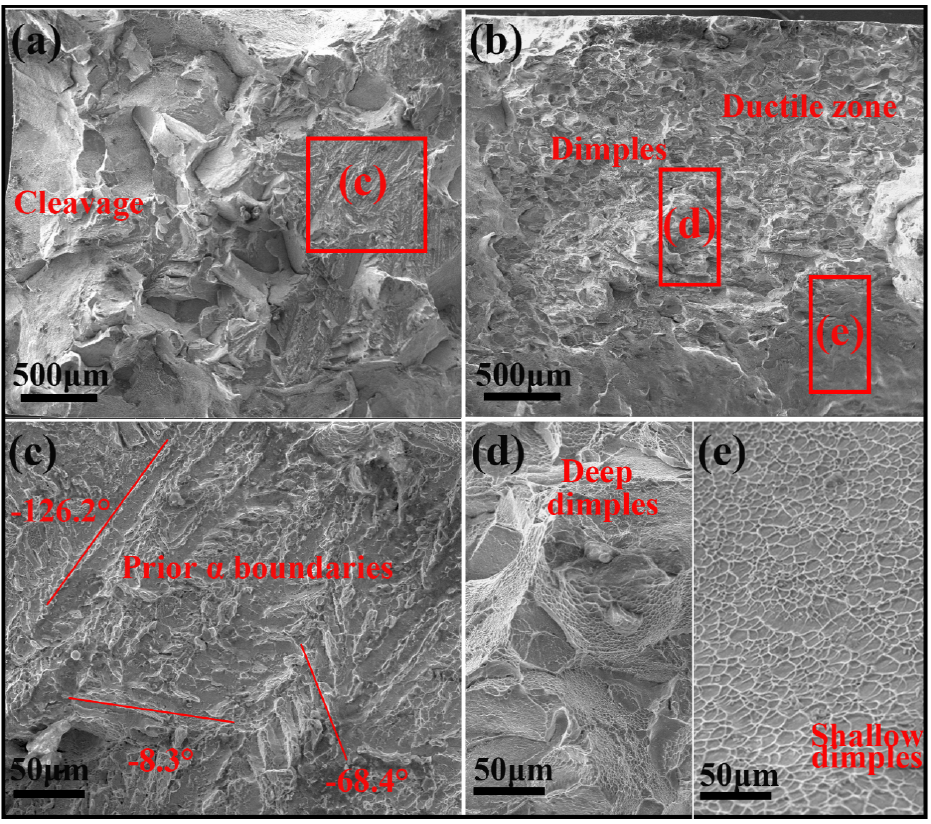
Materials 2020 , 13 , x FOR PEER REVIEW 10 of 14 Whereas, the similar morphology was not observed in the surface of sample 80% CR+ aging (Figure 10b). Meanwhile, a micro-crack is clearly observed in a high-magnification image (Figure 10c), and it Figure 9. Fractographs of ( a ) sample 0% + aging and ( b ) sample 80% + aging; high-magnification is also clear that the crack path was blocked at the β grain boundary, which is accordance with the Figure 9. Fractographs of ( a ) sample 0% + aging and ( b ) sample 80% + aging; high-magnification higher ductility of sample 80% CR+ aging. images of area c in Figure 9a ( c ), and areas d and e in Figure 9b ( d , e ), respectively. images of area c in Figure 9a ( c ), and areas d and e in Figure 9b ( d , e ), respectively. To clarify failure mechanisms during dynamic loading, the profile-view SEM images close to the fracture surface of these two samples were further analyzed, as shown in Figure 10. Two long and narrow adiabatic shear bands (ABS) are noted in sample 0% CR+ aging (Figure 10a), which are distinct from the matrix. Moreover, a long crack propagated along one of the bands. It means adiabatic shear failure occurs in sample 0% CR+ aging during dynamic loading. ABS, as an unstable deformation mode, unually developes in Ti and Ti-alloys during high strain-rate or/and high temperature deformation due to their low heat conductivity and high adiabatic shearing sensitivity.